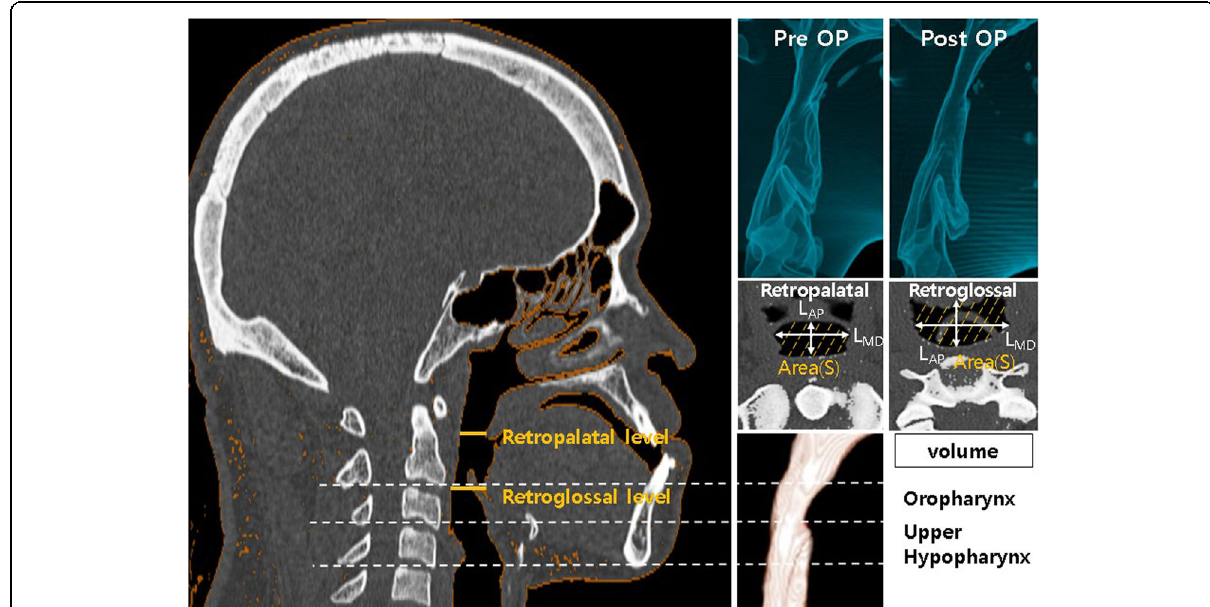
Fig. 1 Measurements in volume, linear distance, and area in the pharyngeal airway. The largest transverse width, anteroposterior length, and cross-sectional area were measured at the level of the most constricted point of the soft palate and tongue base. The airway was divided as follows, and each volume was measured for the oropharyngeal area (between CV1 line and CV2 line) and the upper hypopharyngeal area (between CV2 line and CV3 line), with the CVn lines being parallel to the FH